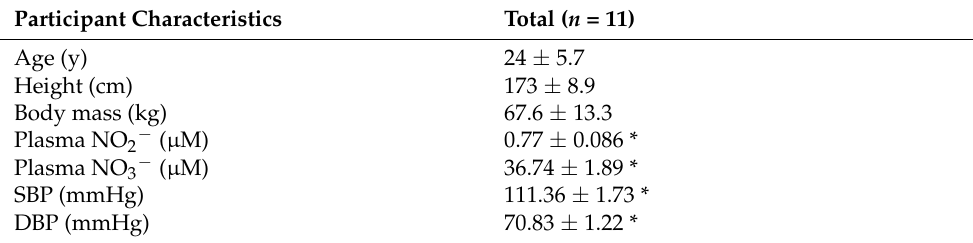
Table 2. Baseline characteristics of participants, Mean ±